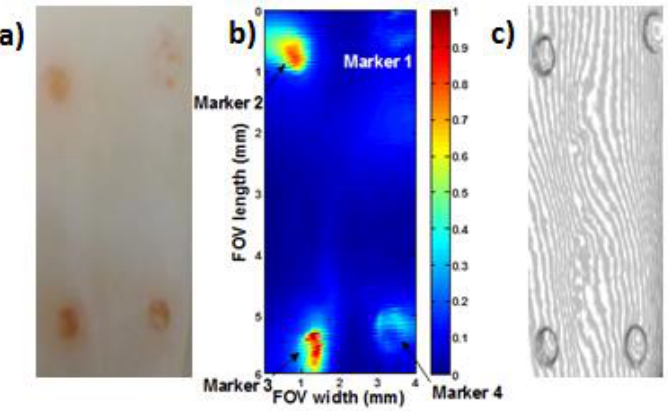
Figure 2. Image comparisons (FOV) between different modalities and white light photo of real tooth: ( a ) Photo of real teeth. ( b ) MFMT background image without the fluorescence signal. ( c ) Reconstructed surface of teeth using micro-CT (Some distortions may happen due to directly capture from 3-D